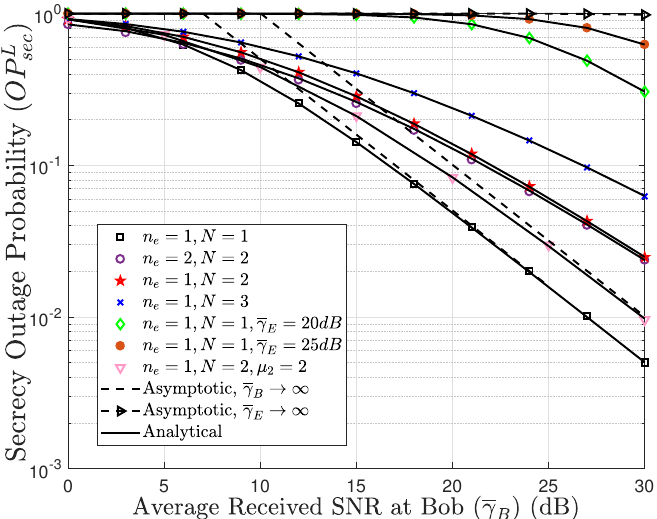
Figure 3. The lower bound of the secrecy outage probability ( OP L sec ) versus the average received SNR at Bob ( ¯ γ B ) . For the main channel, κ = 0, µ = 1, and for the wiretap channel, κ e = 0, µ e = 1 (Rayleigh). C th = 1, K = 2, and ¯ γ E = 1 dB.